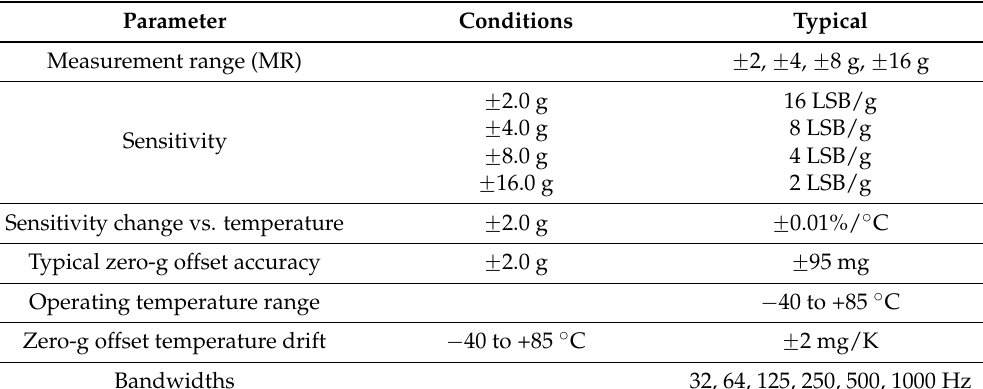
Table 2. Mechanical characteristics of the accelerometer in the iPhone 5S.